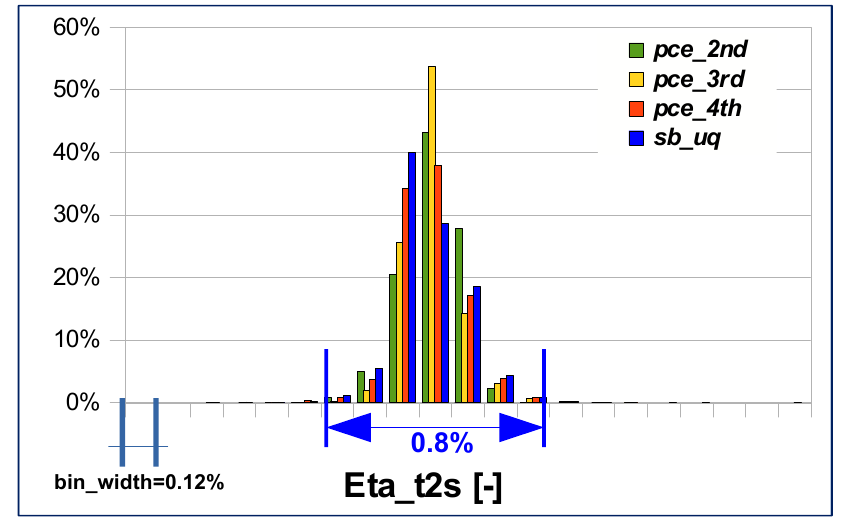
Figure 14. PCE vs. SB-UQ: rotor efficiency probability distributions coming from different polynomial orders. Table 7. Rotor e ffi ciency maximum absolute probability di ff erences from SB-UQ approach.